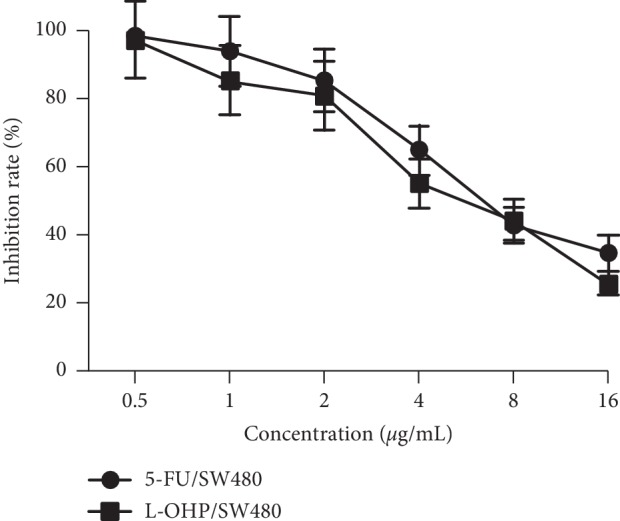
Cell proliferation assay. 5-FU/SW480 and L-OHP/SW480 drug-resistant cell strains were inoculated into 96-well plates at a density of 1 × 105 cells per well, and 20 μL, 10 μL, 5 μL, 2.5 μL, and 1.25 μL of compound matrine injection was added. After 48 h of culture, the cell inhibition rate gradually increased with an increase in the concentration of compound matrine injection. The 50% inhibitory rates of 5-FU/SW480 and L-OHP/SW480 cells were 0.84 and 0.89 g/mL, respectively, which were used as nontoxic doses to reverse drug resistance.